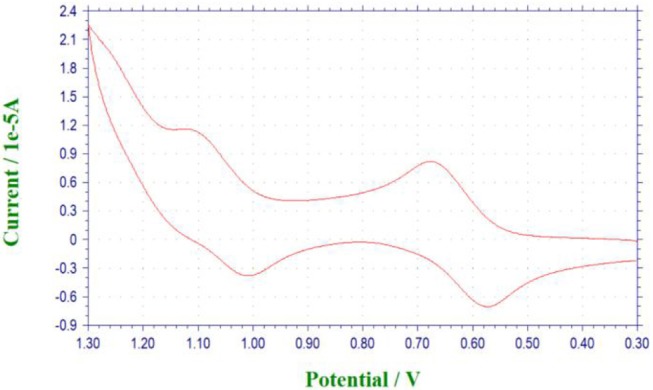
Cyclic voltammogram (scan rate = 100 mV s−1) of the P[5]4R (5.00 × 10−4 M) in CH2Cl2.